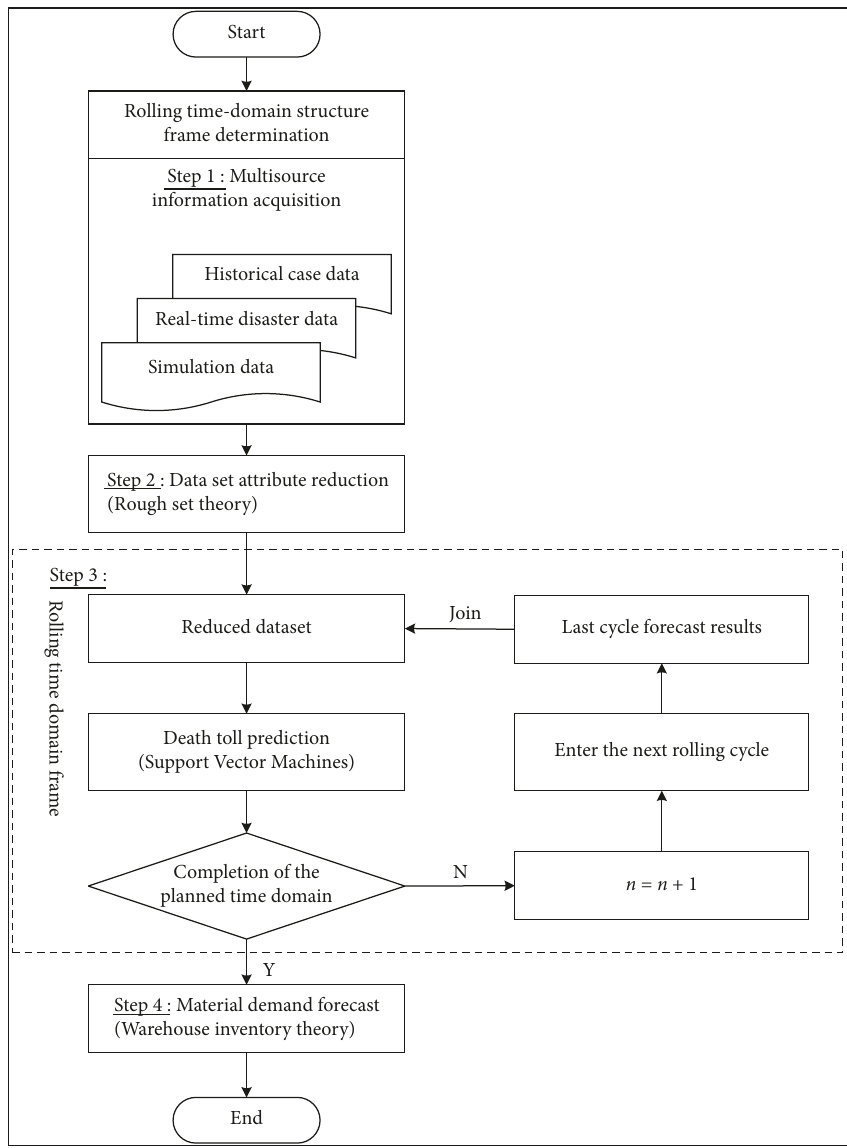
Figure 1: Technological